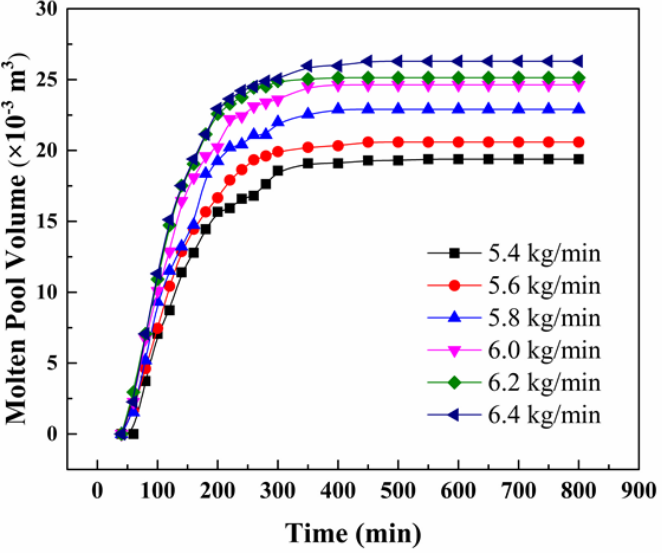
Figure 5. Changes in molten pool volume and depth.